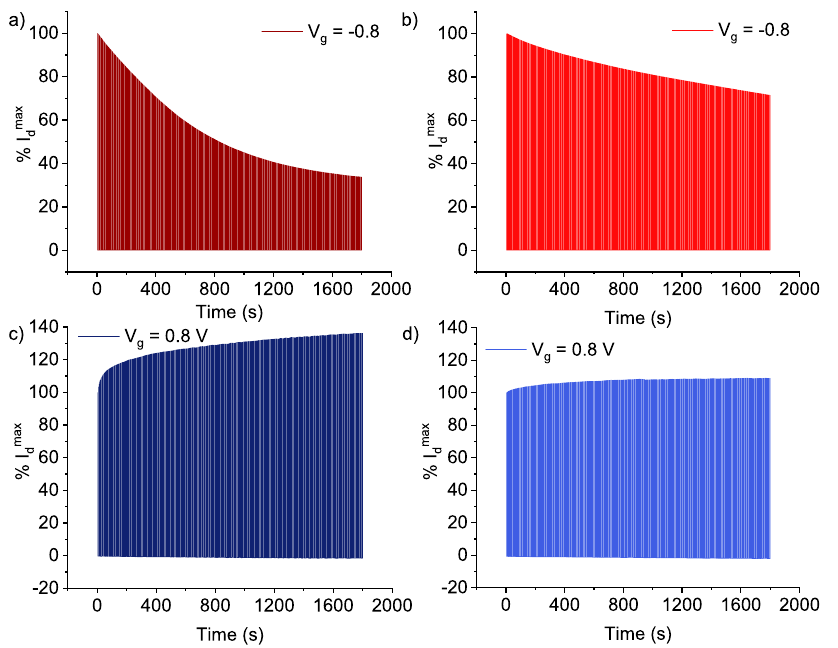
Fig.6|OECTstabilitymeasurementsin0.1MNaClaqueouselectrolyte. Probingstabilitybycycling V g andrecording I d over30min.Thegraphsindicatethepercentage decrease in drain current ( I d ) for a unpuri fi ed p(g 4 T2-TT), b F2 of p(g 4 T2-TT), c unpuri fi ed p(C 6 g 3 NDI-T), and d F2 of p(C 6 g 3